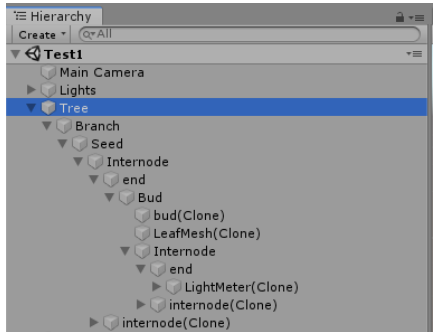
Figure A1. Hierarchy in Unity© showing a simple early tree structure: one branch, two internodes, two